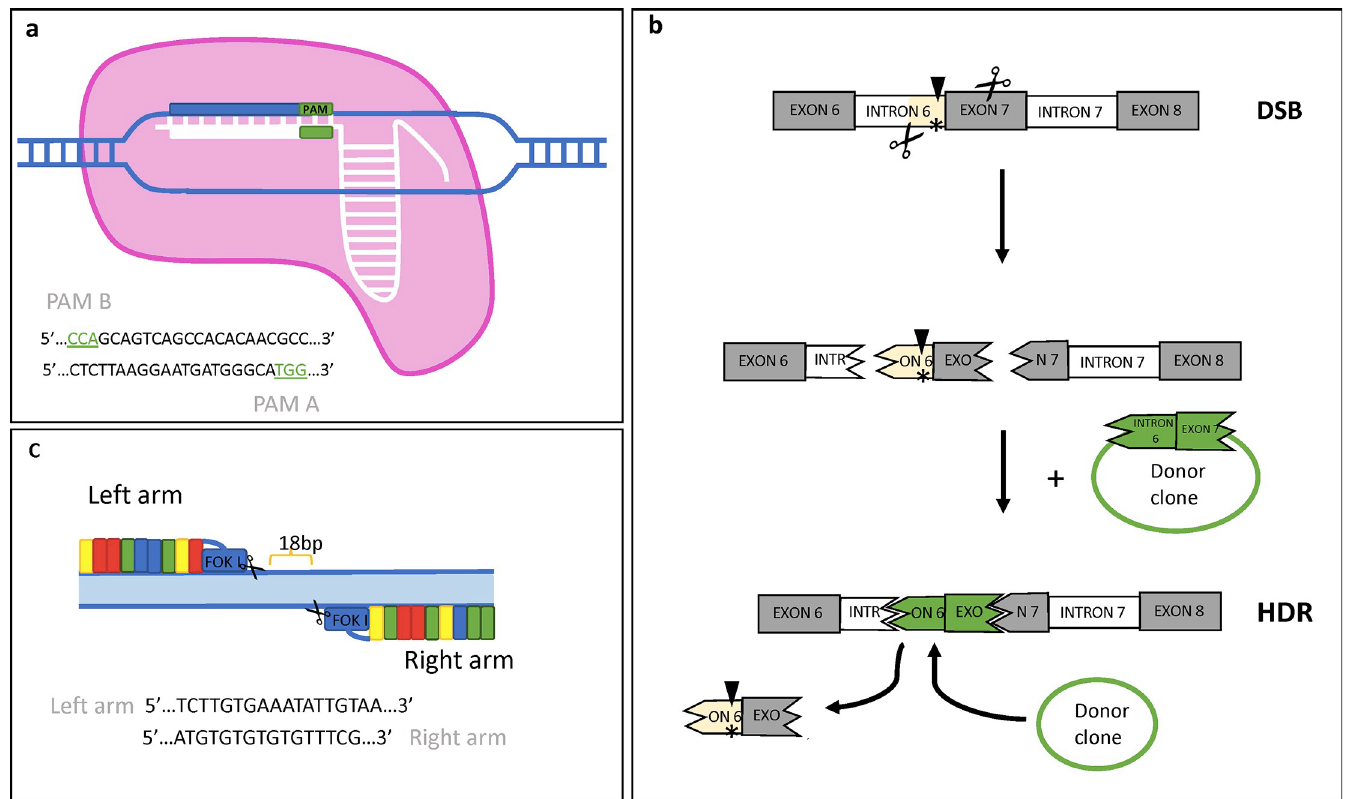
Fig 1. Experimental design of HDR-mediated CRISPR/Cas9 and TALEN gene editing for the GRMD mutation. (a) Guide selection included sgRNA A (PAM A underlined) and sgRNA B (PAM B underlined). (b) Experimental design. Double stranded breaks (DSB) occurred at the intron 6 area (highlighted) and/or at the exon 7 area to excise the GRMD mutation (asterisk). The donor clone (green) was used as a template for HDR to replace the excised area with the corrected DMD gene sequence. The black arrow designates the cutting site for Sau96I restriction enzyme, used to genotype GRMD dogs. When the dog does not have the mutated bp, Sau96I does not cut the DNA. (c) TALEN arm design with left and right